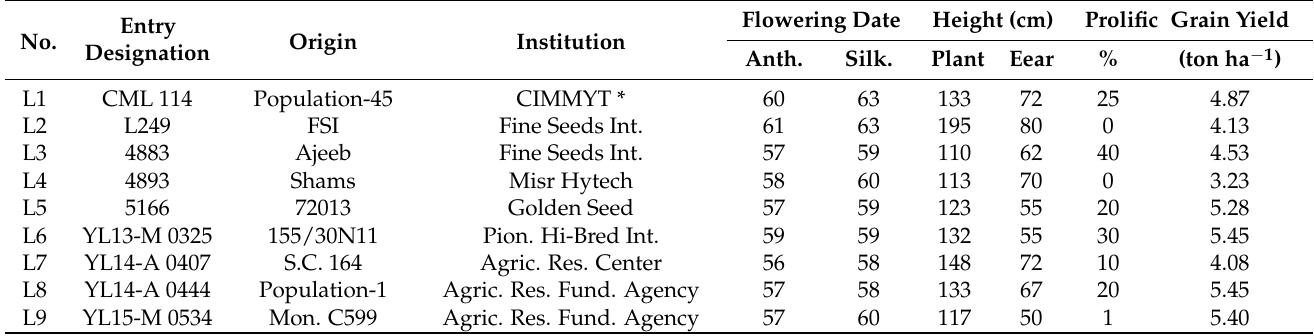
Table 8. Designation, origin, and place of 9 inbred lines (L) that were used in this study.